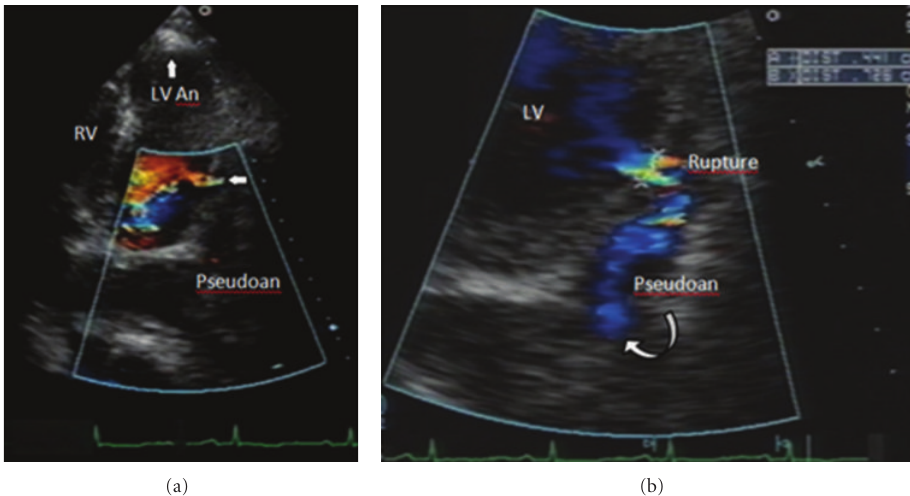
Figure 2: (a) Transthoracic two-dimensional and color Doppler echocardiogram in four-chamber view, showing the left ventricular apical aneurysm (LVAn), the site of rupture (arrow) and the pseudonaeurysm formation (curved arrow). (b) Zoom in lateral wall rupture with color Doppler.